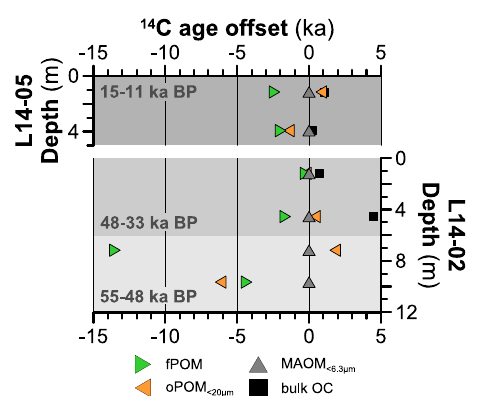
Fig. 2 | Mass partitioning of bulk organic matter (OM), composition of OM fractions and the bioavailably of mineral-associated OM (MAOM <6.3 µ m ). Data is shown for thermokarst sediments (L14-05) and Yedoma deposits (L14-02) under changing climate during the late Pleistocene, along with a Siberian paleo- temperatures (based on ref. 48) for the three depositinal time frames (55 – 48, 48 – 33,and15 – 11kabeforepresent — BP);NomaterialwasdepositedduringtheLast GlacialMaximum(LGM25 − 19kaBP);Furthershownare b bulkorganiccarbon(OC)